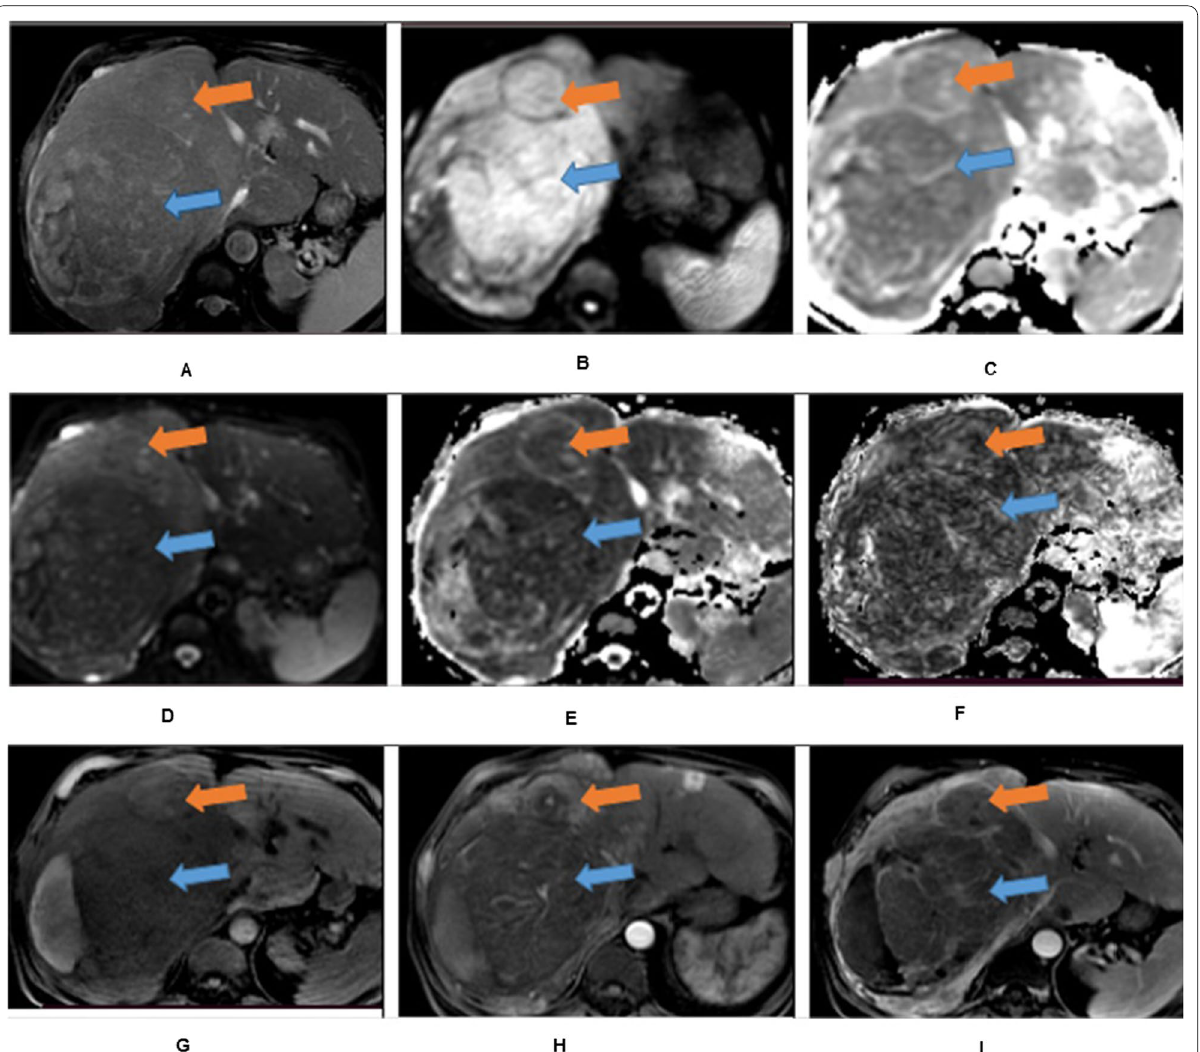
Figure 6 and Table 5 show that 1. FA values had AUC of 73.7% with 95% confidence interval ranges between 61.7 and 85.8%, the sensitivity was 87.1%, and the speci- ficity was 73.9% and cut-off value at 0.345 with a signifi- cant P value of < 0.001. 2. DTI-ADC values had AUC of 84.5%, 95% confidence interval ranges between 75.2 and 93.9%, the sensitivity was 88.7% and the specificity